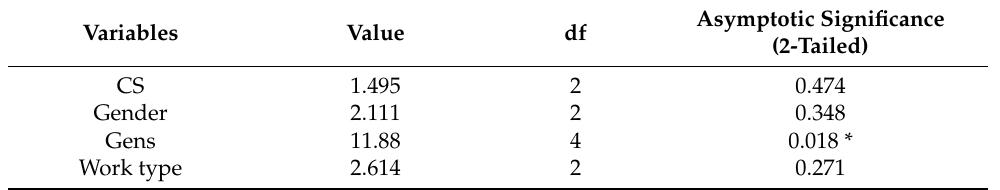
Table 5. Results of the chi-square